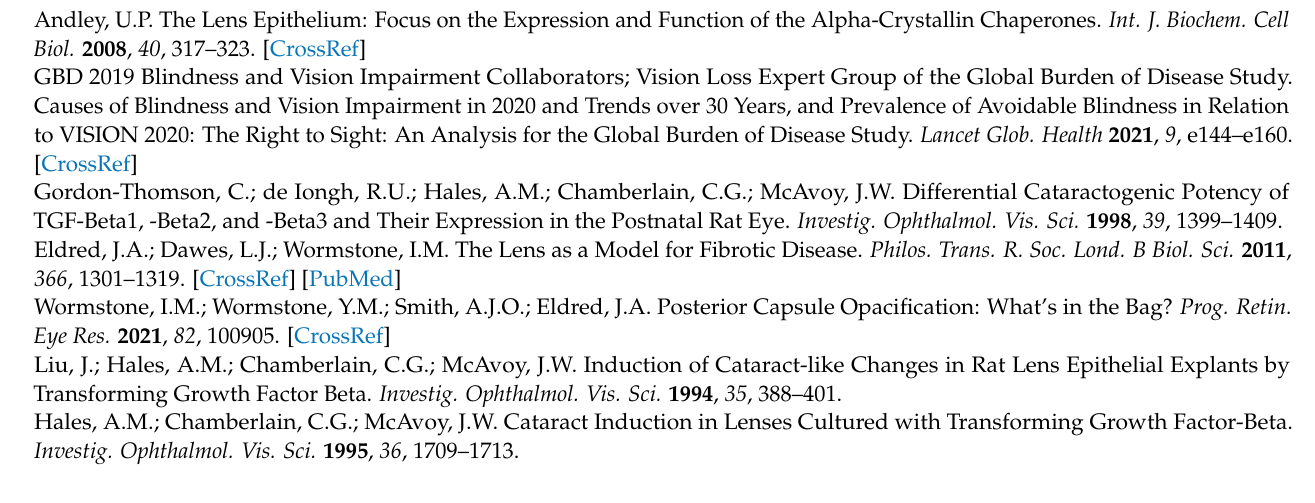
mouse whole lenses; Figure S4: Bioinformatic analyses of the potential role of H19 in regulating TGF- β 2-induced EMT in lens epithelial cells; Figure S5: Validation of the potential H19/miR675-3p/Smad4 axis and temporary exclusion of imprinting effects; Figure S6: H19 -ICR heterozygote mice displayed lens dysmorphogenesis or